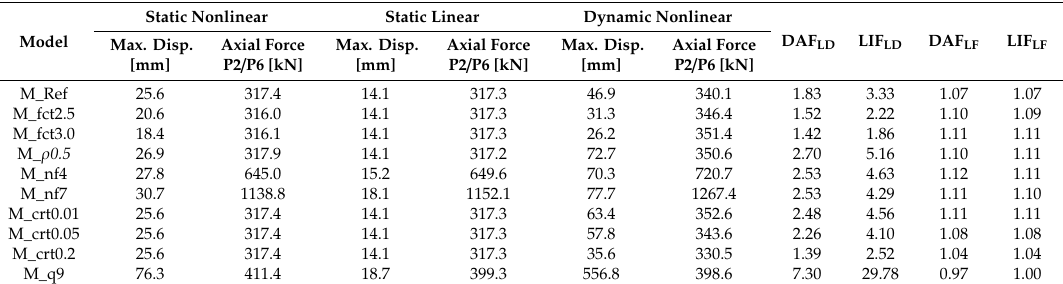
Table 7. Dynamic Amplification Factors (DAFs) and Load Increase Factors (LIFs) for displacements (DAF LD and LIF LD ) and forces (DAF LF and LIF LF ). Static Nonlinear Static Linear Dynamic Nonlinear Model